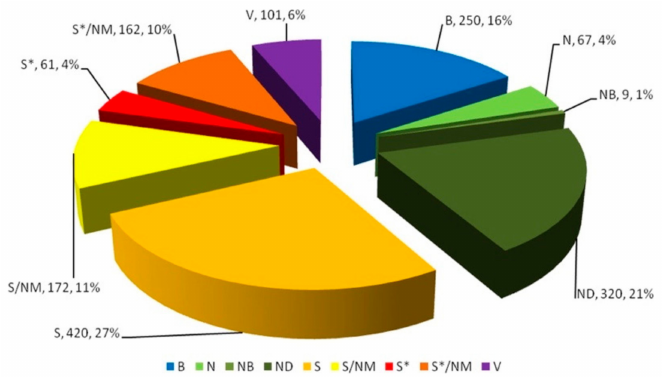
Figure 2. All approved drugs between 1981–2014 that were based on small-molecule; n = 1211. B: Biological macromolecule, N: Unaltered natural product, NB: Botanical drug (defined mixture), ND: Natural product derivative, S: Synthetic drug, S*: Synthetic drug (NP pharmacophore), V: Vaccine, /NM: Mimic of natural product [14] Reprinted with